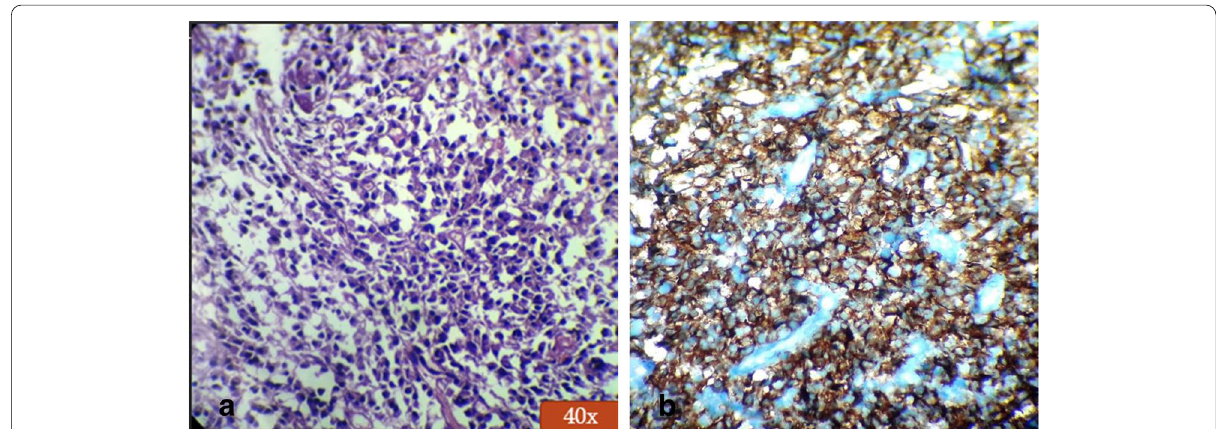
Fig. 3 a Histopathological examination showing diffuse sheets of round to plasmacytoid cells b Immunohistochemistry showing CD 138